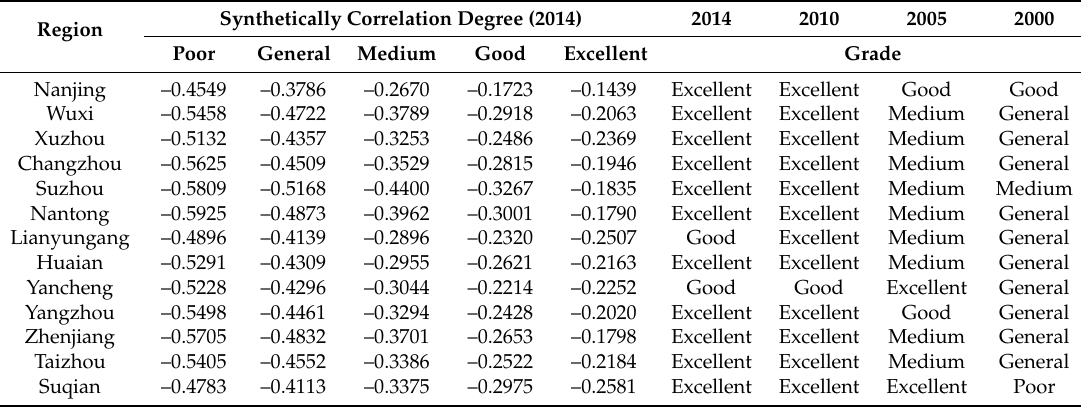
Table 5. Synthetically correlation degree and matter grade of UEH in 2000, 2005, 2010, and 2014.